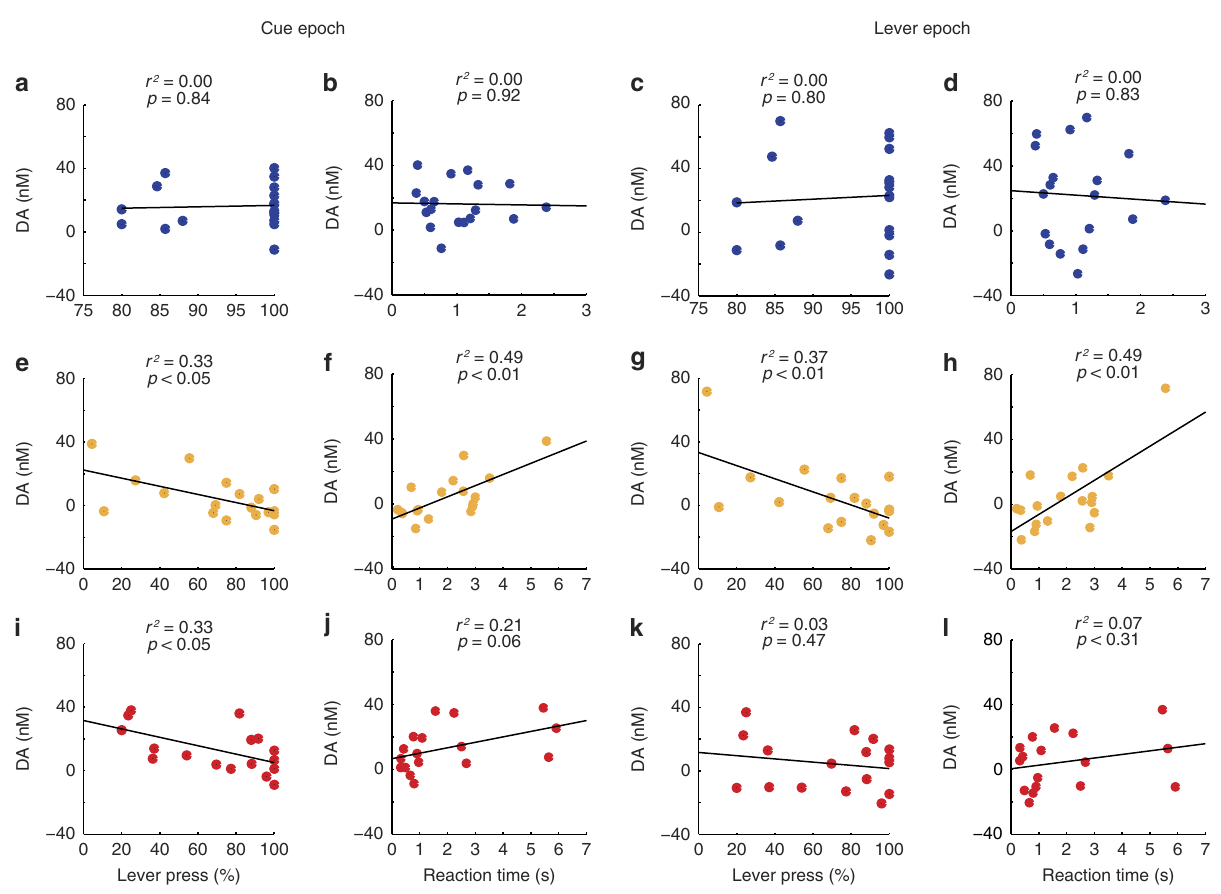
Figure 3 | Correlation of DA release with behavioural measures. Each dot represents an individual session; all recording sessions are represented. ( a – d ) DA release is not significantly correlated with lever press or reaction time for reward trials (blue). ( e , f, i , j ) DA release is negatively correlated with lever press and positively correlated with reaction time for both neutral (yellow) and shock (red) trials during the cue epoch. ( g , h ) DA release is negatively correlated with lever press and positively correlated with reaction time for neutral trials in the lever epoch. ( k , l ) DA is not significantly correlated with behavioural measures for shock trials during the lever